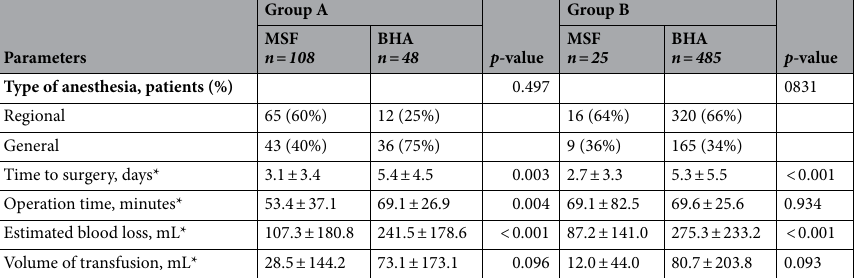
Table 2. Comparison of surgery-related parameters between patients with MSF and cementless BHA according to fracture type. *Expressed as average ± standard deviation. † Surgical approach statistically compared between Group A and B. MSF, multiple screw fixation; BHA, cementless bipolar hemiarthroplasty; n , numbers.